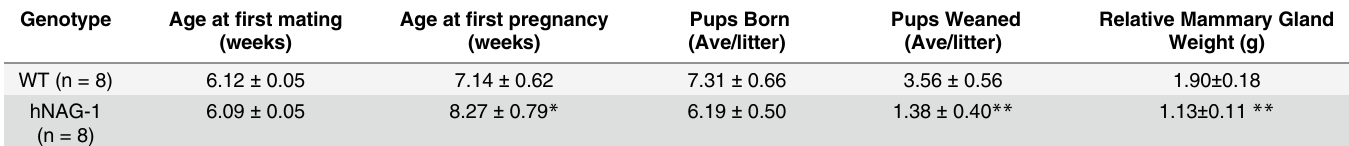
Data shown is average +/- SEM and statistics were analyzed by Mann-Whitney tests. P values are two sided for age at mating and fi rst successful pregnancy and one sided for number of pups born and weaned compared to WT for each